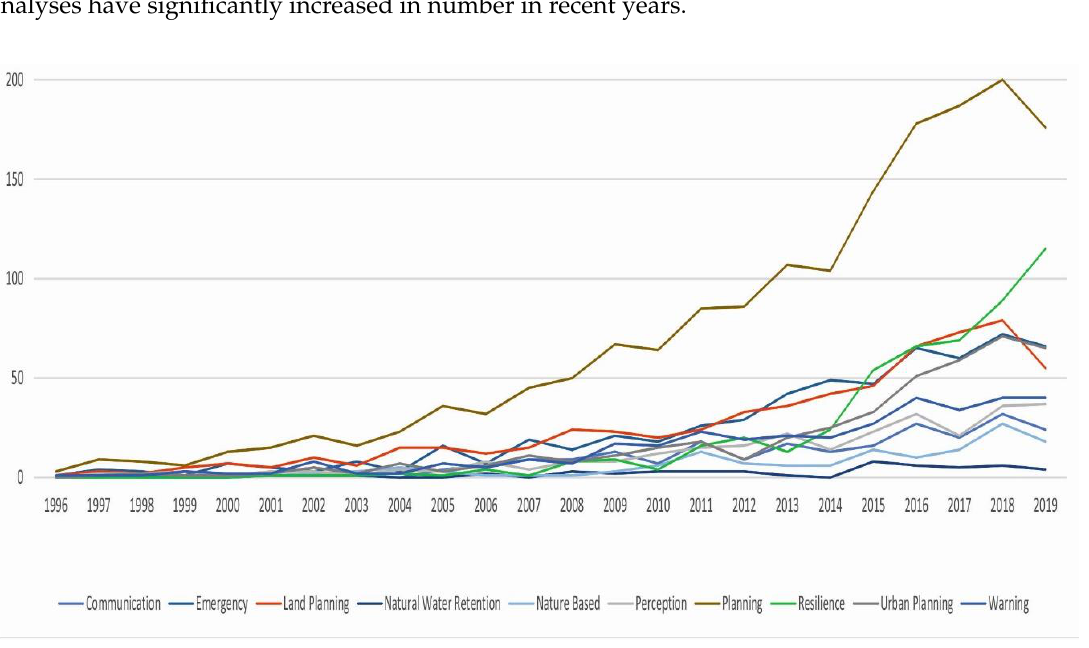
Figure 2. Temporal evolution of scientific/technical publications (records) on the main fields of application of FRA in the WOS database (search: “flood” AND “risk” AND “assessment” BY (fields of application)), from 1996 to 2019 [5].